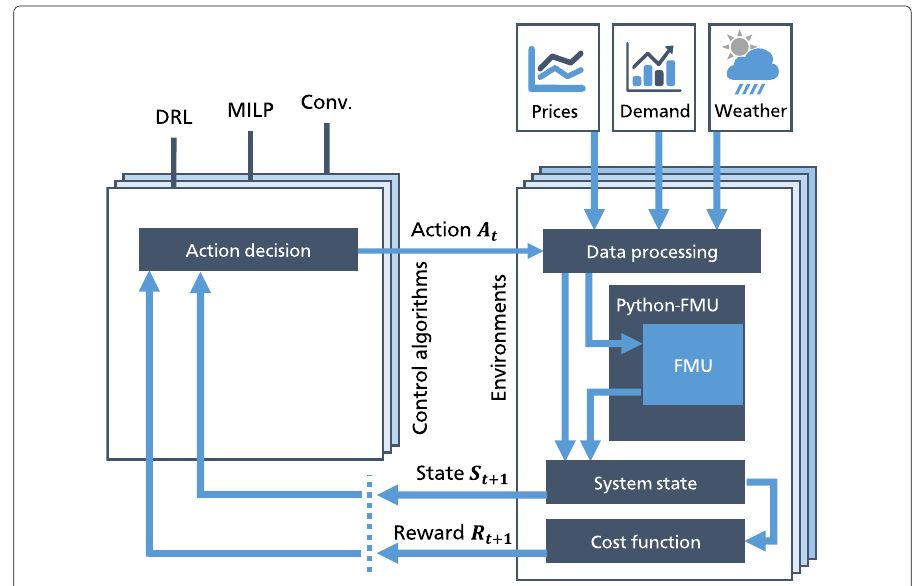
Fig. 3 Framework. The different algorithms are represented by the multiple layers on the left side, whereas the multiple layers on the right side represent the possibility to interact with various environments, as described in the section Case Study (Panten et al.